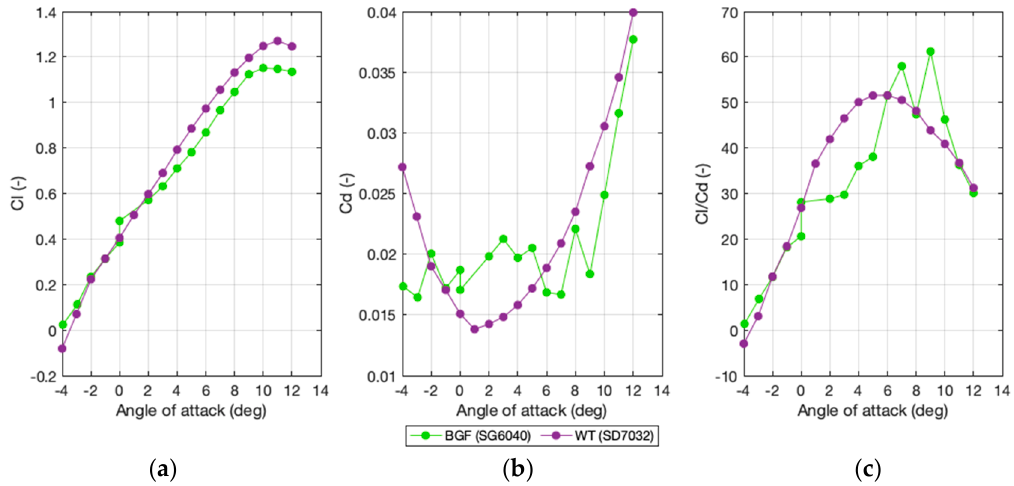
Figure 4. Two-dimensional sectional model tests of the SG6040 airfoil ( a ) and of the SD7032 ( b ). In both models, the pressure loop is seen at the midspan and the wake rake downstream of the test section.